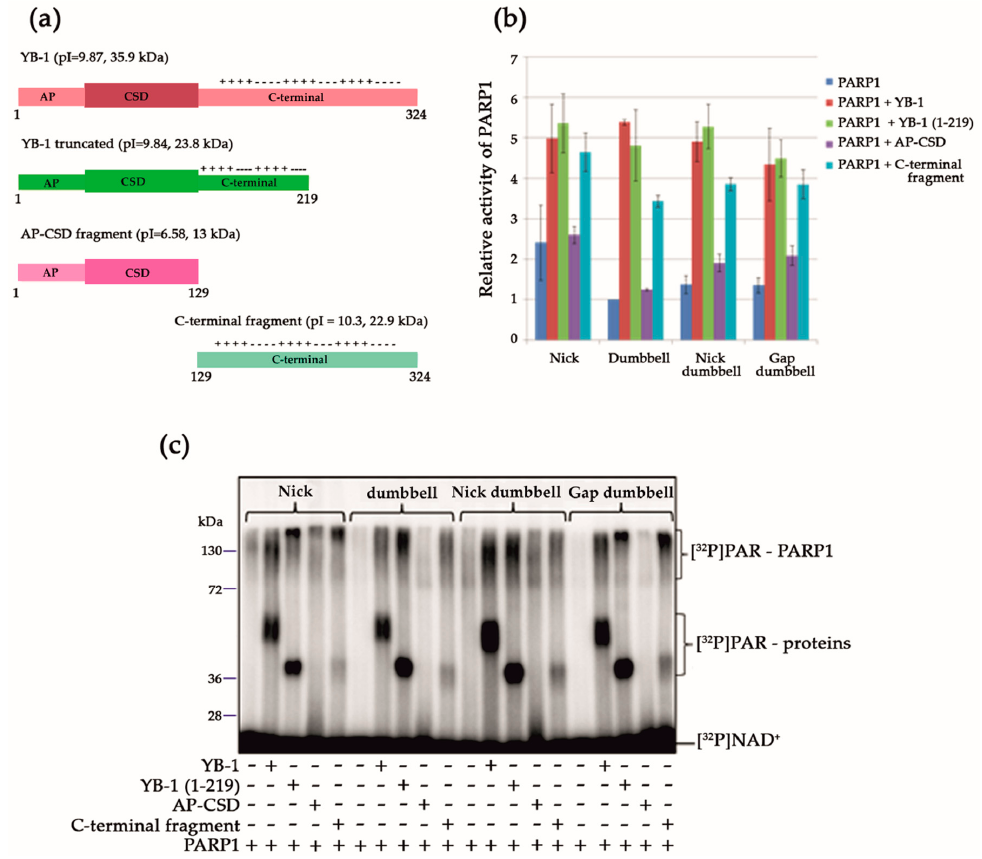
Figure 3. The C-terminal fragment of YB-1 is su ffi cient to stimulate PARP1 activity. ( a ) Schematic view of the YB-1 constructs employed in this study. ( b ) Quantification of PARP1 activity. PARP1 (100 nM) was incubated with 100 nM DNA substrate, and 4 µ M NAD + and [ 32 P]NAD (0.4 µ Ci) in the presence of 1600 nM YB-1 or its mutant (where indicated). 32 P-PAR–modified proteins were TCA-precipitated and counted. The relative level of PAR synthesis was normalized to the level of PAR synthesis catalyzed by PARP1 alone for 15 min with dumbbell DNA substrate. The experiments were performed at least three times; the histogram presents the means ± SD of three independent experiments. ( c ) Protein PARylation in the presence of DNA duplexes and [ 32 P]NAD according to SDS-PAGE and phosphor imaging. The reaction mixtures contained 100 nM PARP1, 1600 nM YB-1 or its mutant (where indicated), 4 µ M NAD + and [ 32 P]NAD (0.4 µ Ci), and 100 nM DNA substrate. AP-CSD, alanine / proline-rich N-terminal domain and the cold shock